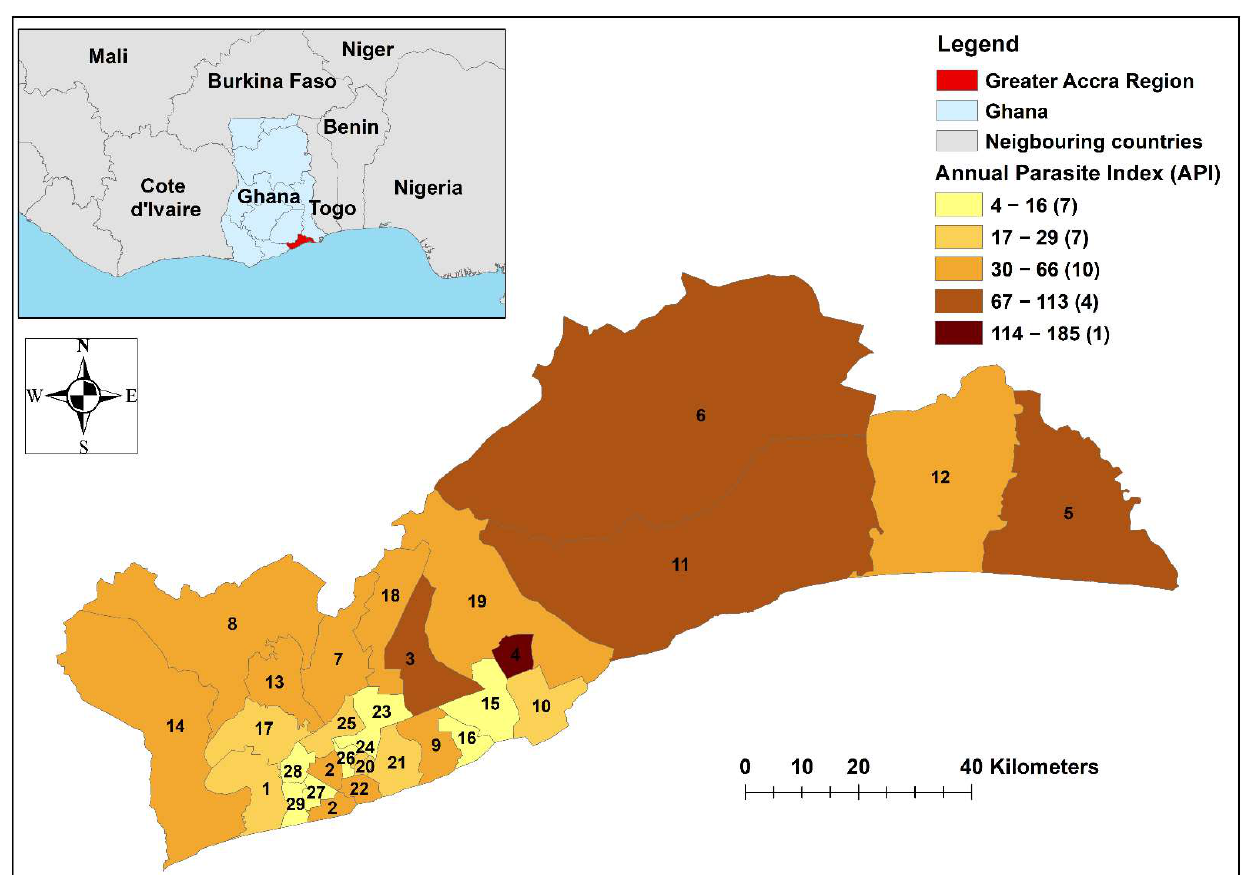
Figure 1. Map of study area (inset) and a choropleth map of the Greater Accra Region indicating the mean number of malaria infections per year (per 1000 people), 2015-2019.